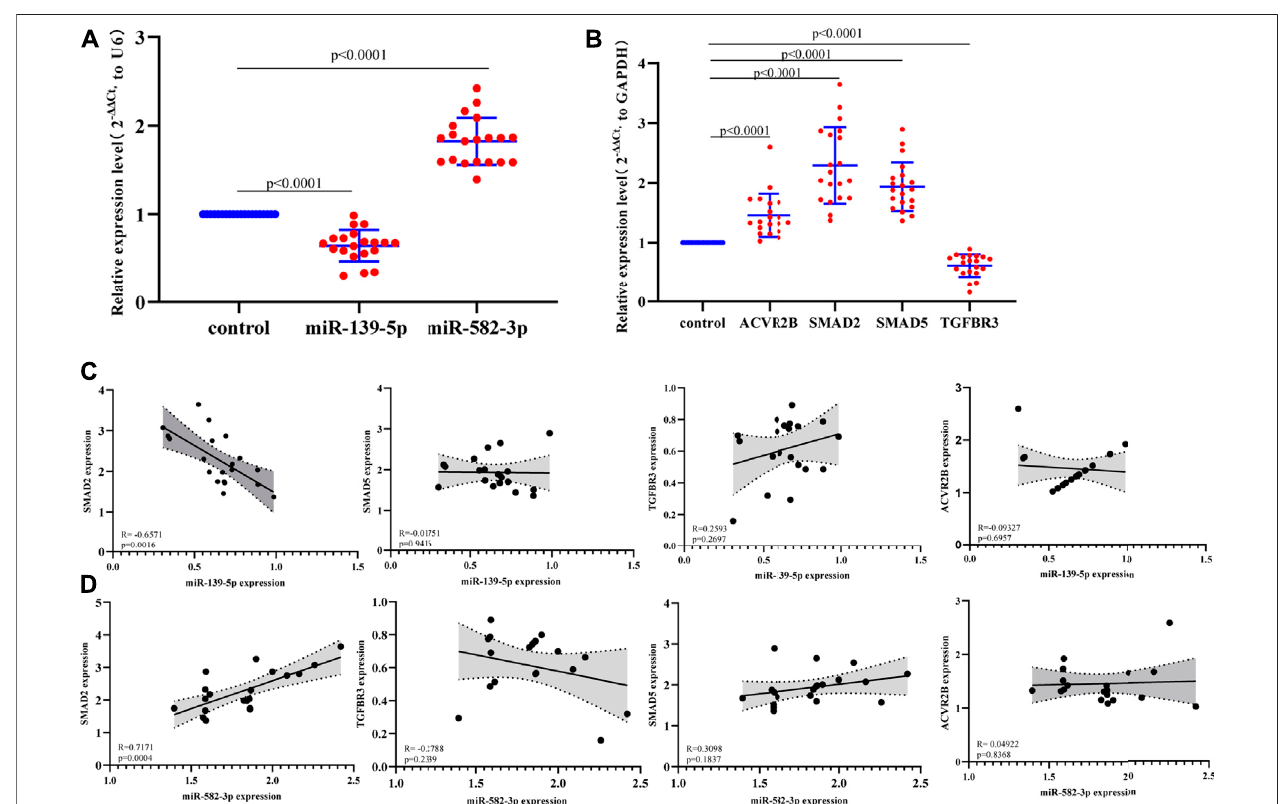
FIGURE5|(A) ExpressionofmiR-139-5pandmiR-582-3pinhepatocellular carcinoma andnormaltissuesbyqPCR.Thedataareshown asthemean±standard deviation. (B) Expression pro fi les of four hub mRNAs (ACVR2B, SMAD2, SMAD5 and TGFBR3) in hepatocellular carcinoma and normal tissues by qPCR. The data are shown as the mean ± standard deviation. (C) Correlation analysis between miR-139-5p and the four hub mRNAs (ACVR2B, SMAD2, SMAD5, and TGFBR3). (D) Correlation analysis between miR-582-3p and the four hub mRNAs (ACVR2B, SMAD2, SMAD5, and TGFBR3).